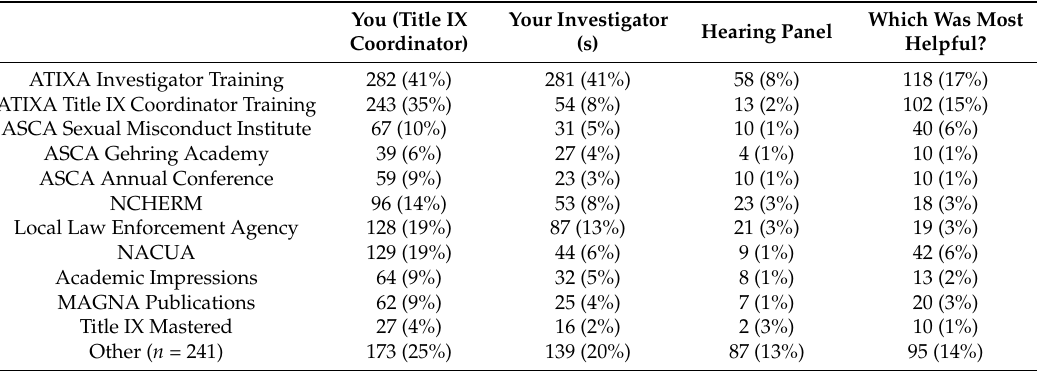
Table 1. Campus Title IX Coordinator